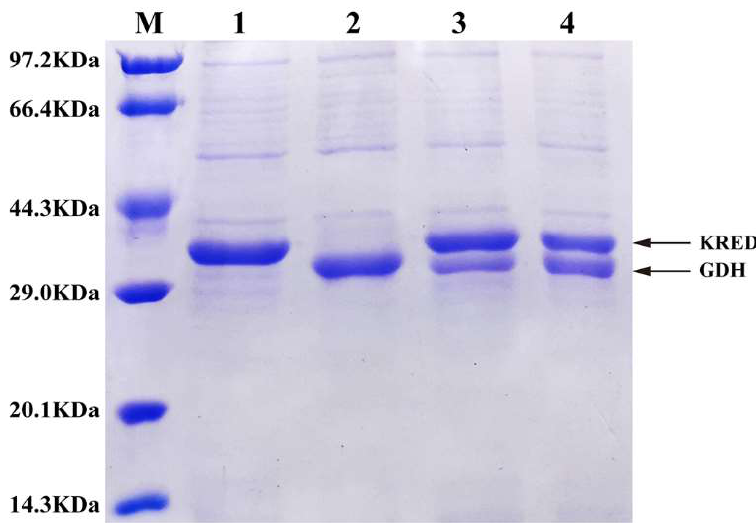
Figure 2. SDS-PAGE analysis of KRED and GDH obtained by different expression strategies. M: protein marker; lanes 1–4: cell-free extract of the strain expressing KRED alone, cell-free extract of the strain expressing GDH alone, cell-free extract of E. coli /pET28-K-rbs-G, cell-free extract of E. coli /pETDuet-K-G.